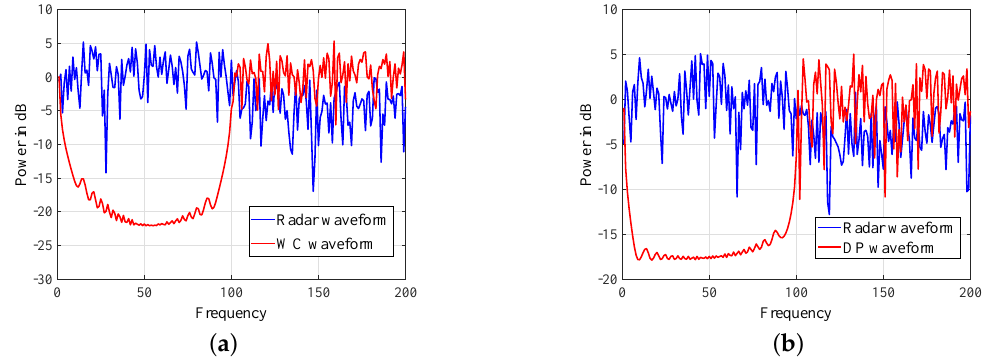
Figure 7. Spectrum of weighted-combining (WC) and dominant-projection (DP). ( a ) Spectrum of WC ( b ) Spectrum of DP.